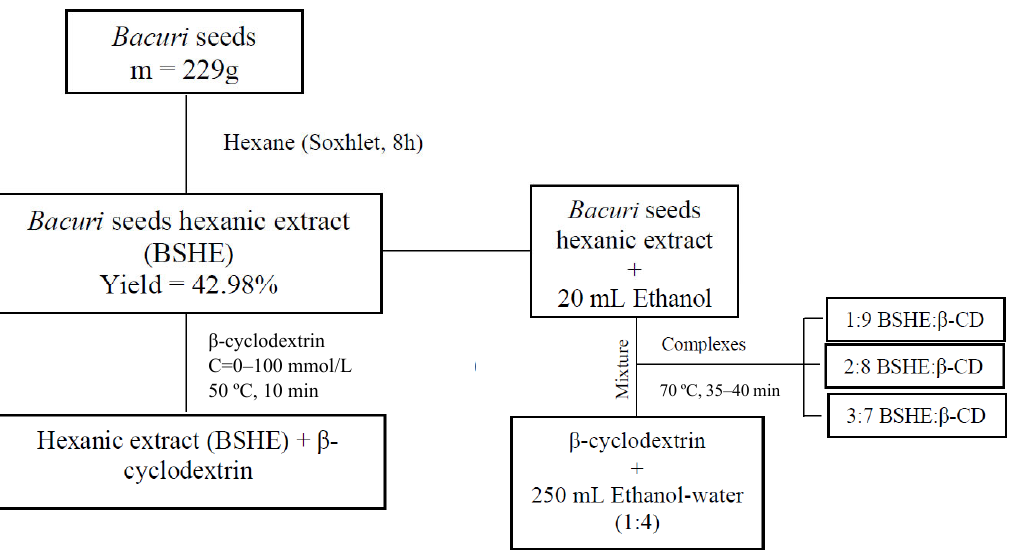
Figure 1. Graphical scheme of extract preparation (BSHE) and procedures for the production of a β‐cyclodextrin inclusion complex with Platonia insignis seed extract. Table 1. Chemical constituents (%) hexanic extract of the seeds of P. insignis Mart.